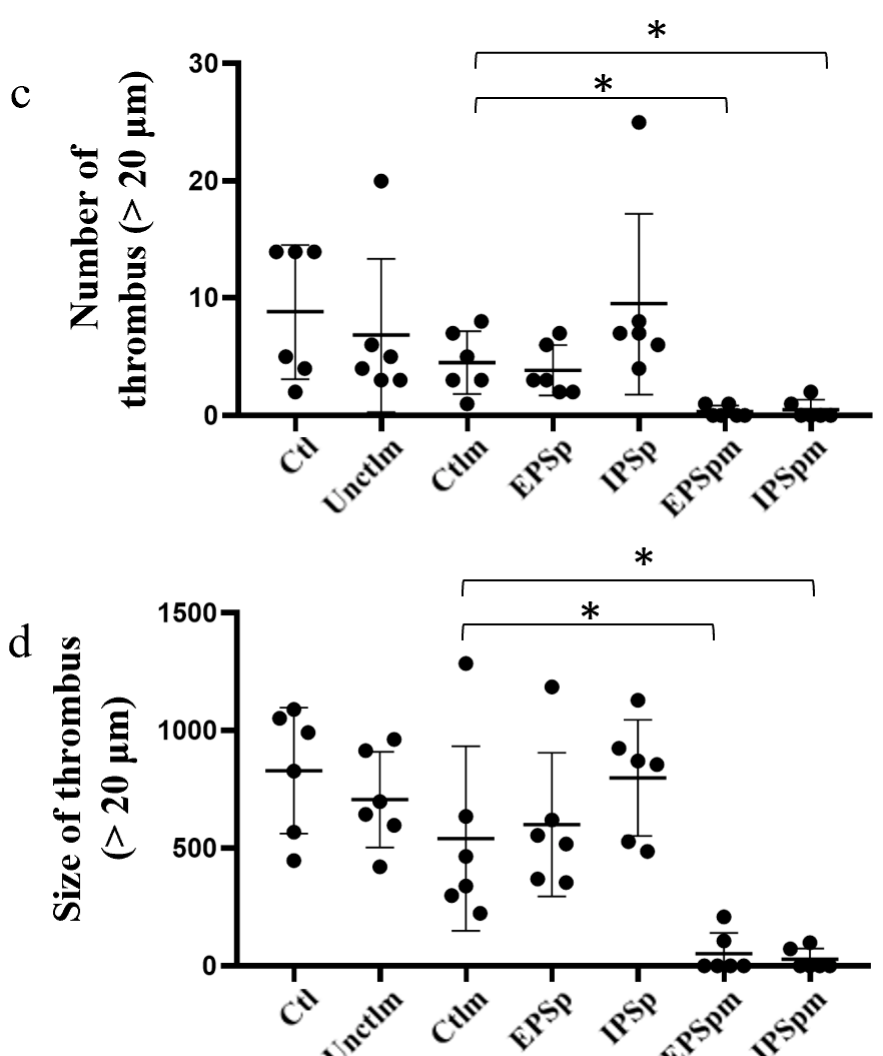
Figure 6. The effects of Cs-4 EPSp, IPSp, and their gut bacterial metabolites on thrombus formation induced by FeCl 3 in C57BL/6J mice. ( a ): Presentative pictures of mesenteric arterioles at different time points, and the red lines indicate the mesenteric arterioles; ( b ): time to 1st thrombus (>20 µ m); ( c ) number of thrombus (>20 µ m); ( d ) size of thrombus over 2 min starting from the time of the first thrombus (>20 µ m). Ctl: phosphate buffered saline; Unctlm: fecal fermentation basal medium before fecal fermentation; Ctlm: fecal fermentation basal medium after fecal fermentation; EPSp: purified Cs-4 exopolysaccharides, IPSp: purified Cs-4 intracellular polysaccharides. EPSpm: EPSp after fecal fermentation; IPSpm: IPSp after fecal fermentation. Each black dot represents a mouse. Data are presented as mean ± standard deviation, n = 6. * p < 0.05, student’s t -test, compared to the control group.